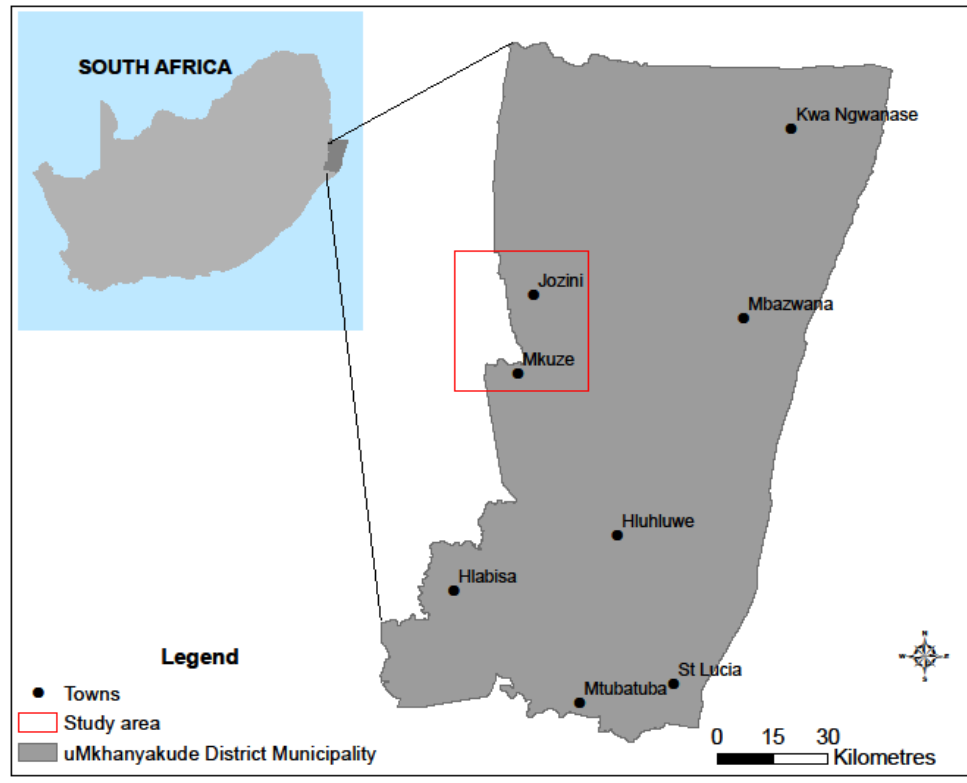
Figure 2. Location of the study area within the uMkhanyakude District Municipality in South Africa.